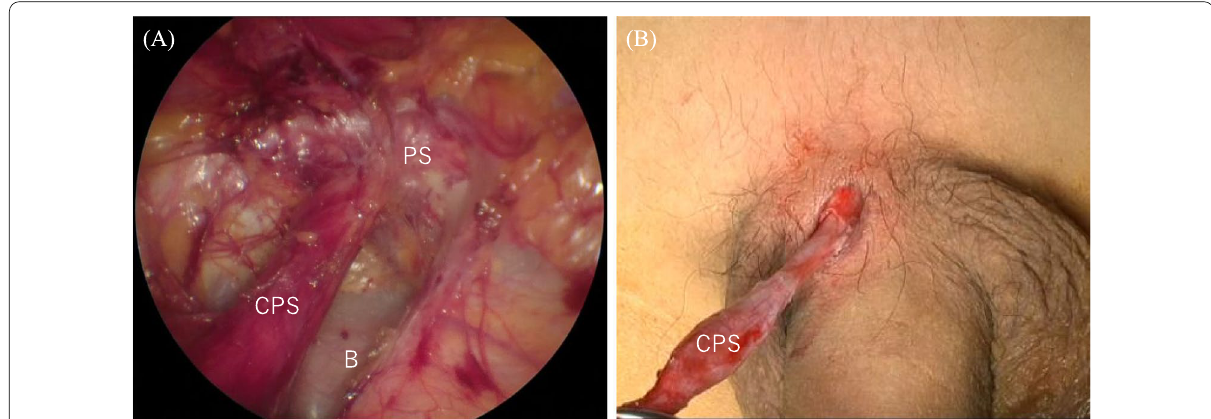
Fig. 4 A A sinus connecting to the pubic symphysis was confirmed and revealed through with the pubic symphysis. B The remaining caudal fistula was removed percutaneously with a small spindle-shaped incision around the fistula opening. CPS congenital prepubic sinus, PS pubic symphysis, B